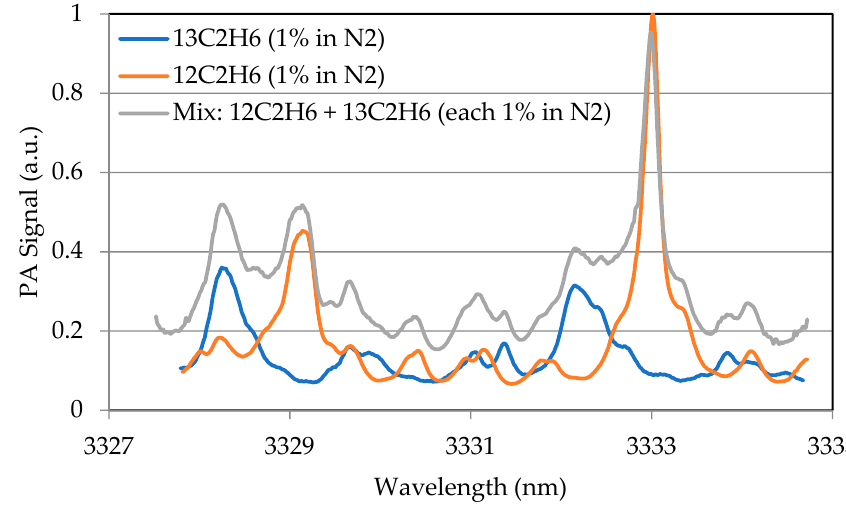
Figure 2. Photoacoustic spectra of 12 C 2 H 6 , 13 C 2 H 6 and a mixture of both isotopologues (ca. 20 °C; 1013